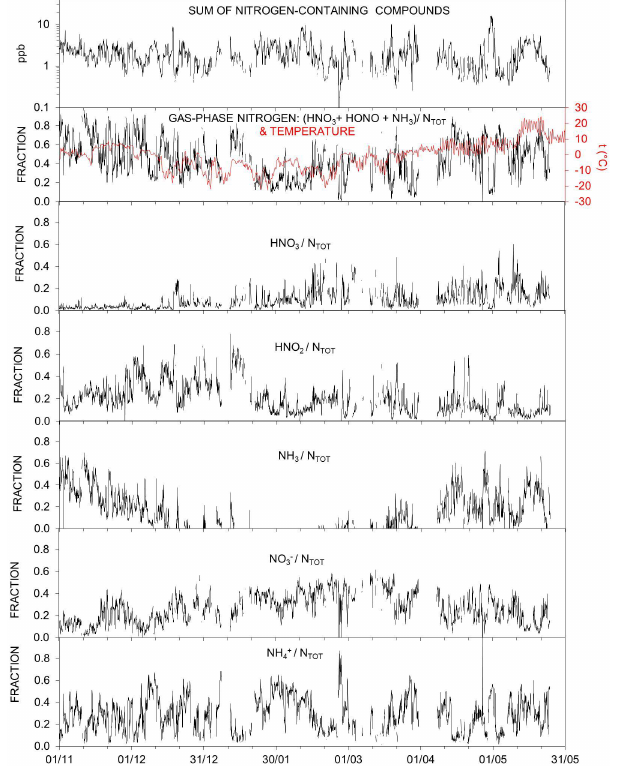
Fig. 11. Nitrogen fractionation into aerosol and gas phases. Up- per panel: Sum of nitrogen-containing gases measurable with the MARGA (HNO 3 + HNO 2 + NH 3 ) and aerosols in PM 10 + NH + ) all in ppb. The panels below that: fractions of (NO − 3 4 nitrogen-containing compounds of the sum of all of them.